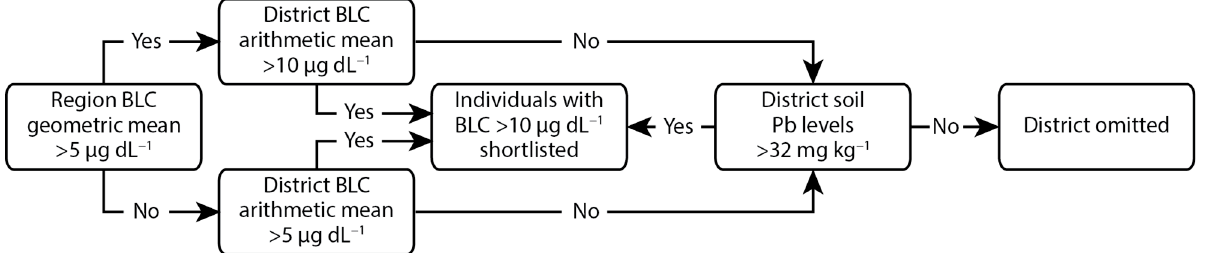
Figure 2. Summary of the criteria used to identify potential candidates based on data from the MICS.